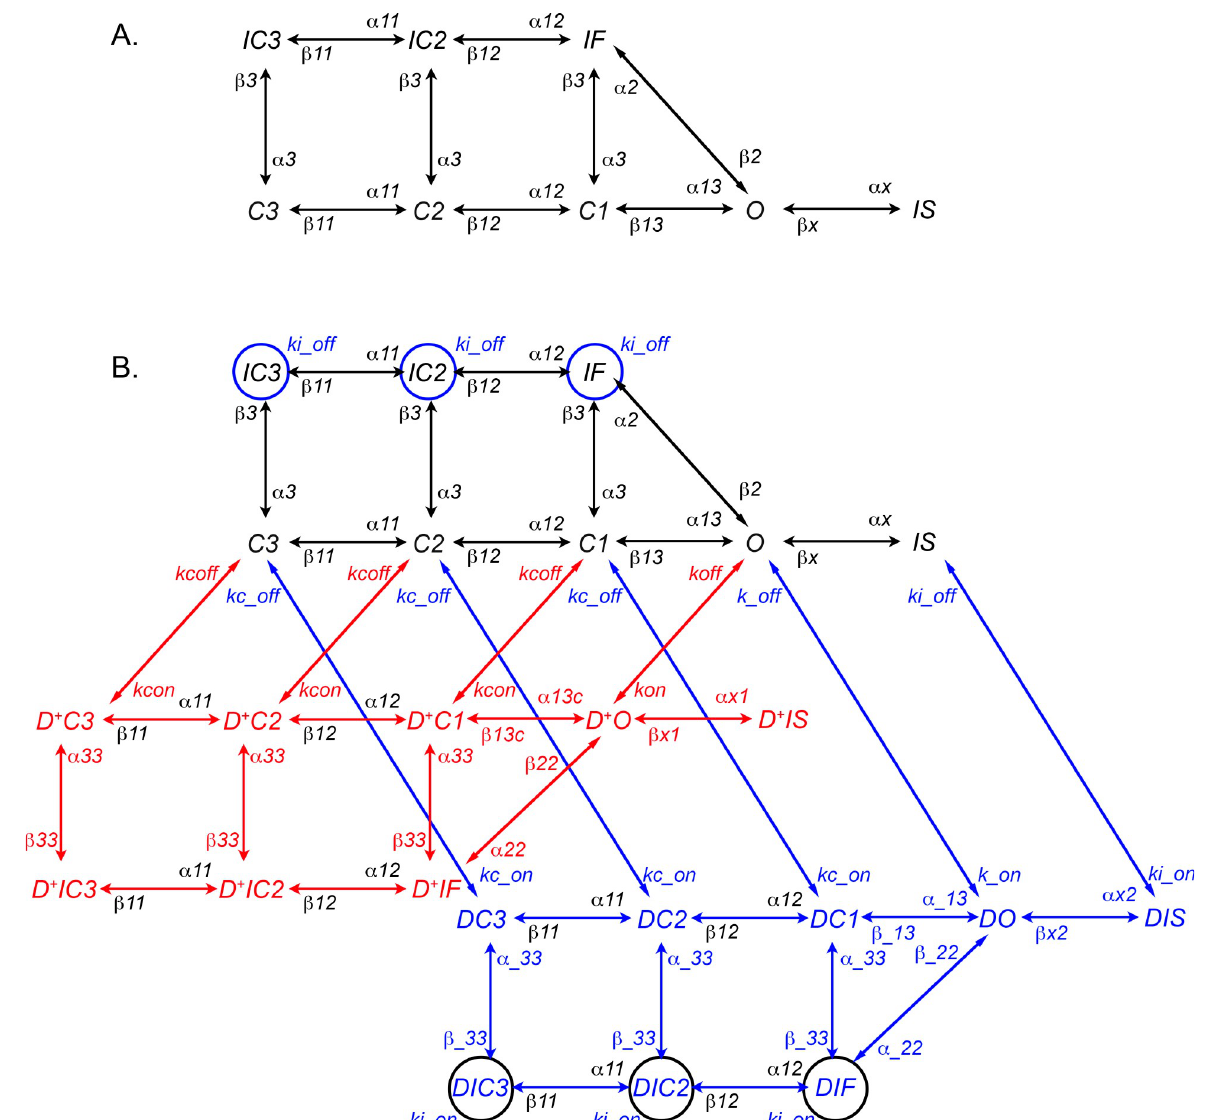
Fig 1. Moreno et al. [4] model of Na + channel-lidocaine interactions. (A) The drug-free Na + channel model. The O state represents the conducting state, while C3, C2, and C1 correspond to 3 closed states. The IC3, IC2, and IF states represent conformational states in which the “fast” inactivation gate is closed, and the IS state represents a state in which a “slow” inactivation gate is closed. Arrows indicate possible conformational state transitions with corresponding voltage-dependent rate constants labeled (e.g., α 13 and β 13 are the rate constants for transitions from C1 to O and O to C1, respectively). (B) The full lidocaine-Na + channel interaction model. The drug-free model from (A) is depicted in black. Red (D + prefix) and blue (D prefix) states represent conformational states where charged and neutral drug is bound, respectively. Charged drug can only bind to non-inactivated states (C3, C2, C1, and O), while neutral drug can bind to any state. Drug binding and unbinding rates are state-dependent, as indicated by the binding and unbinding rates of charged drug to the open state (kon and koff) and closed states (kcon and kcoff), and neutral drug to the open state (k_on and k_off), closed states (kc_on and kc_off), and inactivated states (ki_on and ki_off). For clarity, blue (black) circles as opposed to arrows were used to indicate neutral drug binding (unbinding) to the fast inactivated states with a rate constant ki_on (ki_off).